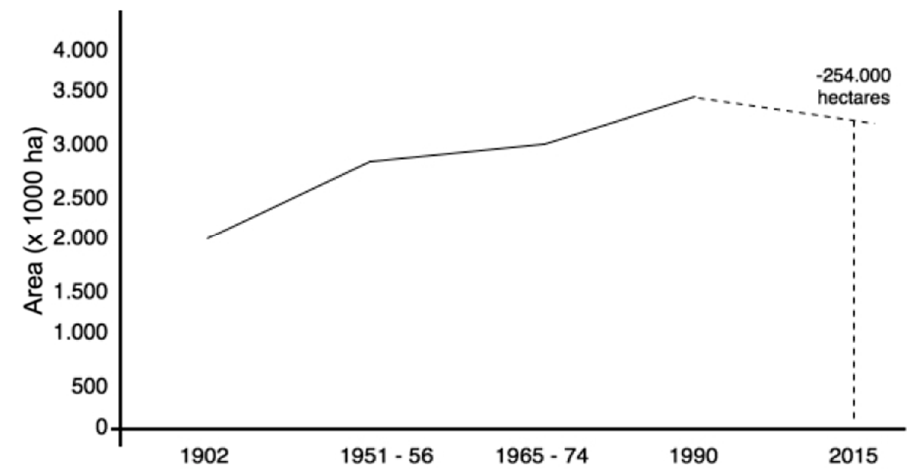
Figure 6. Changes in the forest area of mainland Portugal between 1902 and 2015 (adapted from